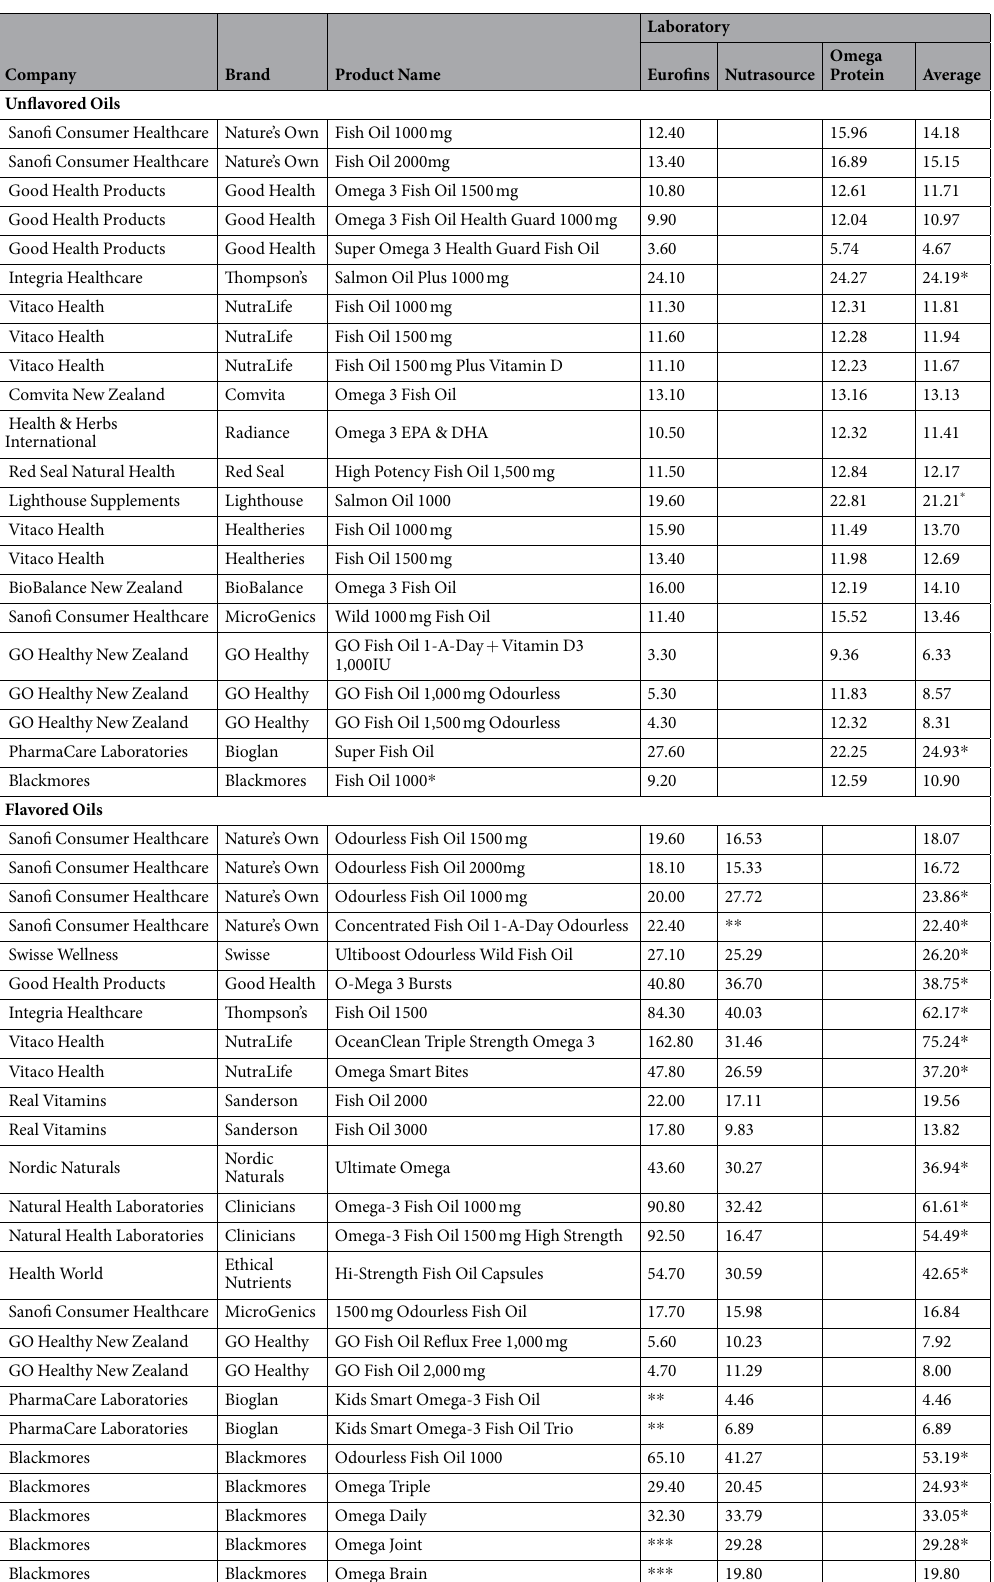
Table 2. p-Anisidine Value test results. * Indicates products where the average result from all laboratories exceeded the GOED Voluntary Monograph limit for p-AV of 20. In the flavored oils these ar e noted for purposes of illustration only, as the p-AV limit is not applicable to flavored oils due to the known interference of flavorings with the method. ** Indicates products for which insufficient sample material was available for testing. *** Indicates products for which insufficient funding for tests was